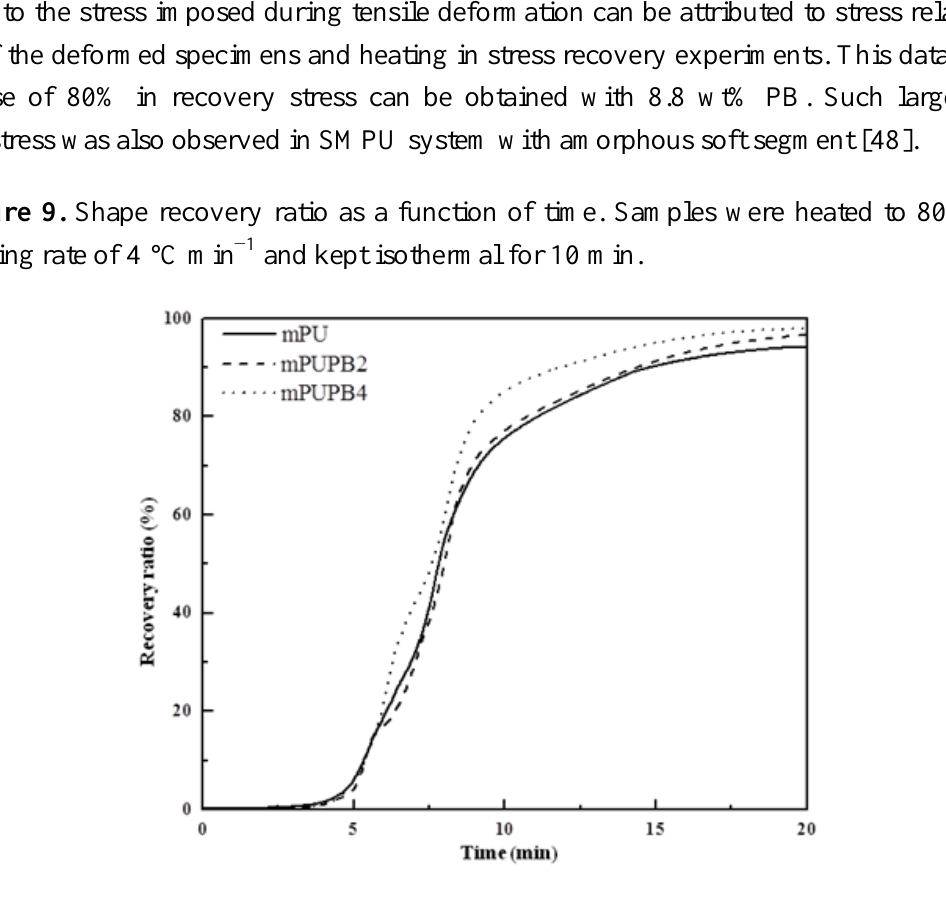
Figure 10. Shape recovery stress of SMPU with crystalline soft segment at 100% fixed strain during heating. Heating rate was 4